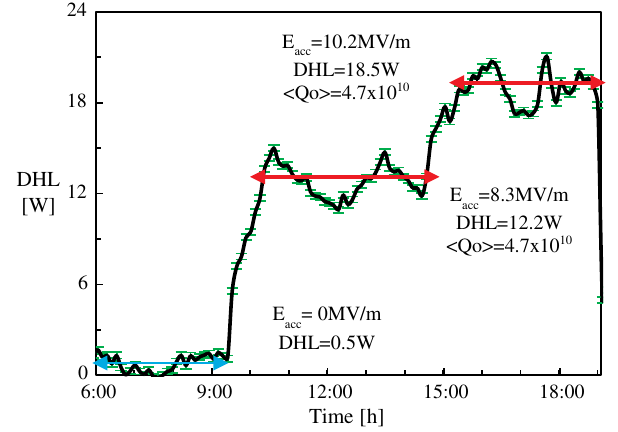
¼ 8 . 3 MV = m and 10 . 2 MV = m at 1.8 K acc ¼ 0 MV = m was acc